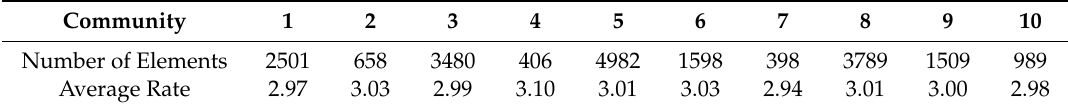
Table 3. Average rates from the local communities.